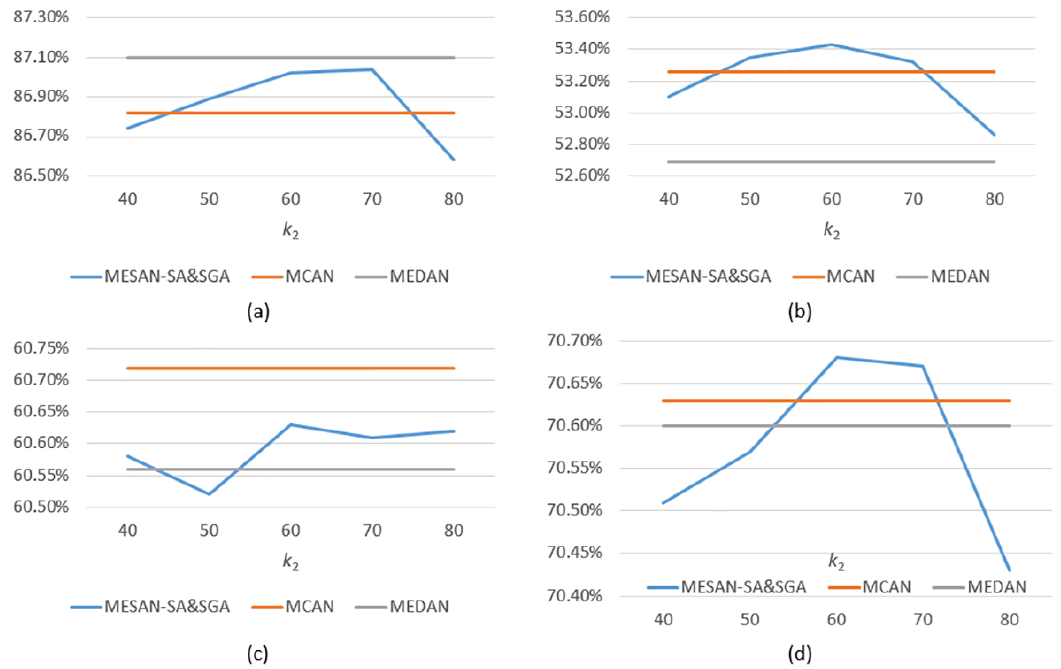
Figure 5. ( a ) The Yes/No accuracy of MCAN, MEDAN, and MESAN-SA&SGA with different k 2 . ( b ) The Number accuracy of MCAN, MEDAN, and MESAN-SA&SGA with different k 2 . ( c ) The Other accuracy of MCAN, MEDAN, and MESAN-SA&SGA with different k 2 . ( d ) The Overall accuracy of MCAN, MEDAN, and MESAN-SA&SGA with different k 2 . All the reported results are evaluated on VQA v2 test-dev